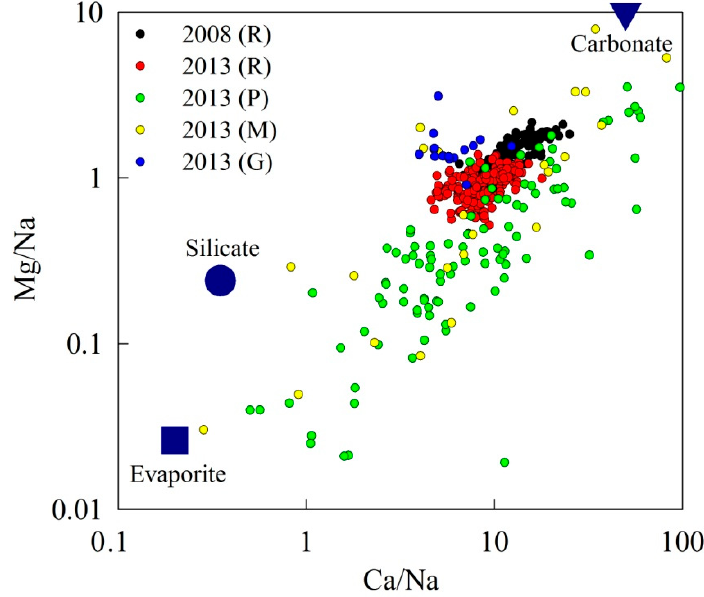
Figure 8. Variations in molar Mg/Na versus Ca/Na (a) in river water (R), precipitation (P), meltwater (M) and groundwater (G) at the Hailuogou basin over two melt seasons in 2008 and 2013, in comparison to the end-members of carbonate, silicate and evaporate weathering.